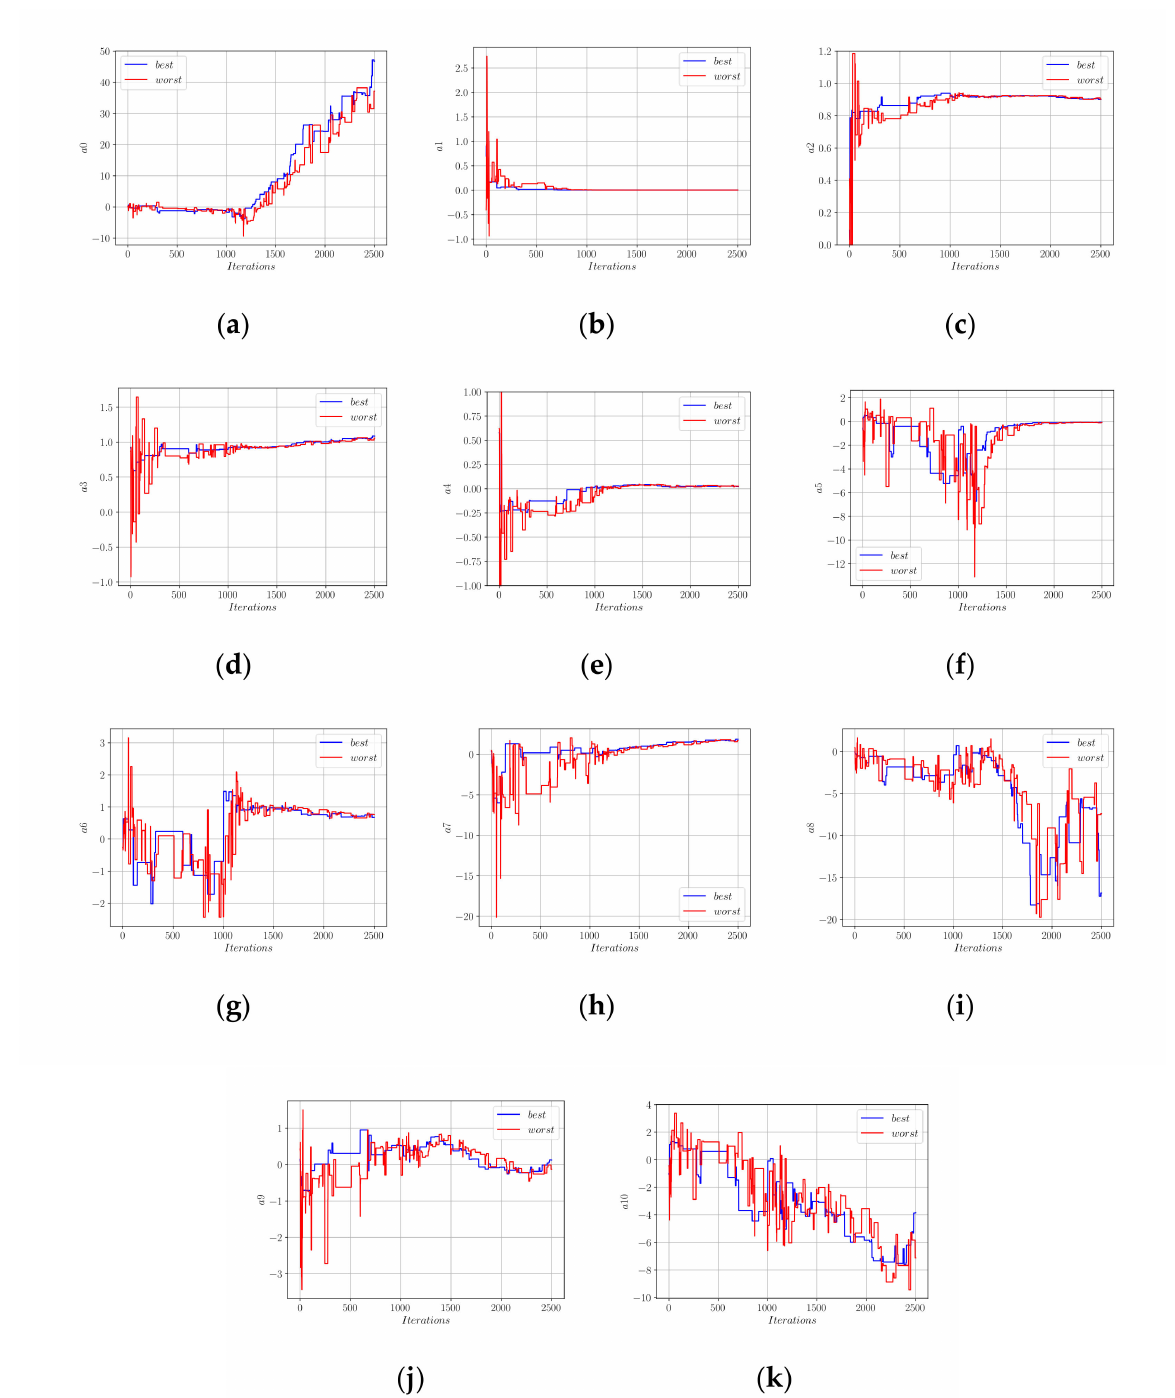
Figure 7. Development of the coefficients in Equation (18); ( a ) a 0 ; ( b ) a 1 ; ( c ) a 2 ; ( d ) a 3 ; ( e ) a 4 ; ( f ) a 5 ; ( g ) a 6 ; ( h ) a 7 ; ( i ) a 8 ; ( j ) a 9 ; ( k ) a 10 . In Figure 7, for each coefficient, the values these coefficients took in the best- and worst- performing members of the population are plotted in blue and red colors, respectively. Using the limit values of the coefficients in Figure 7, Equation (18) can be rewritten as in Equation